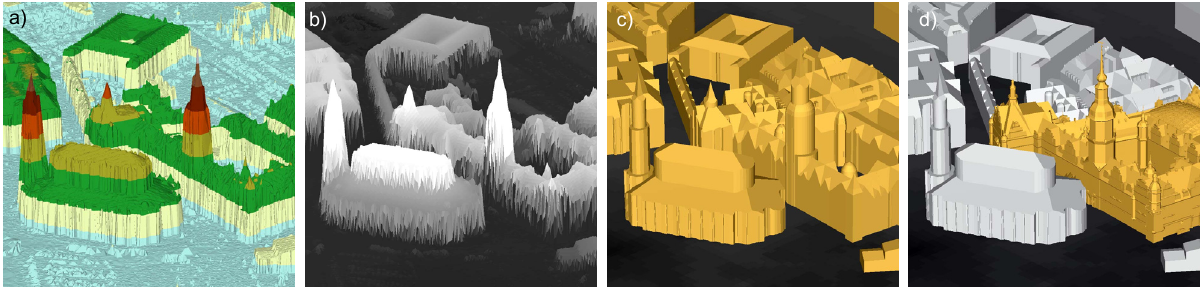
Figure 1. Methods and precision of city modelling – example of Dresden: a) TIN model based on airborne LIDAR data; b) raster model, cell size: 1m; c) LoD2 vector model; d) LoD3 vector model with building